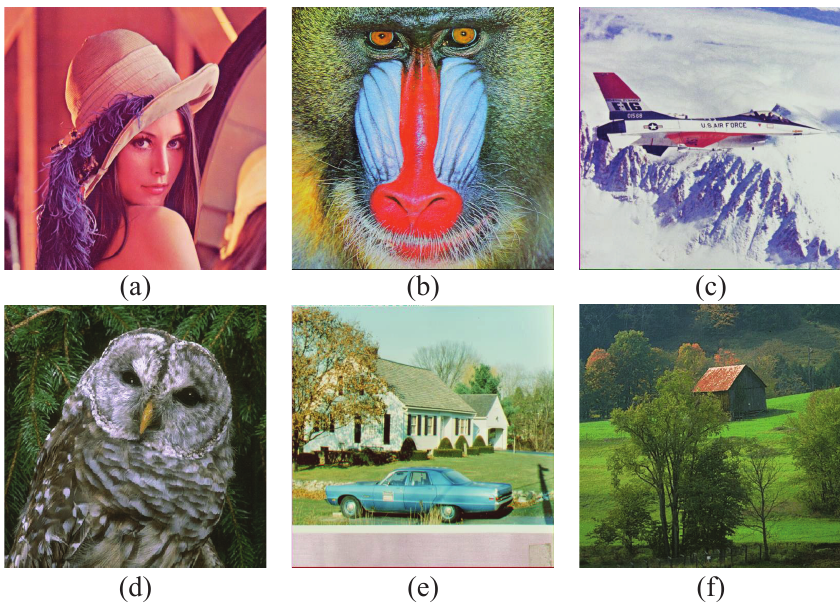
Figure 3. The color host images: ( a ) Lena, ( b ) Baboon, ( c ) Avion, ( d ) Bardowl, ( e ) House, ( f ) Barnfall.